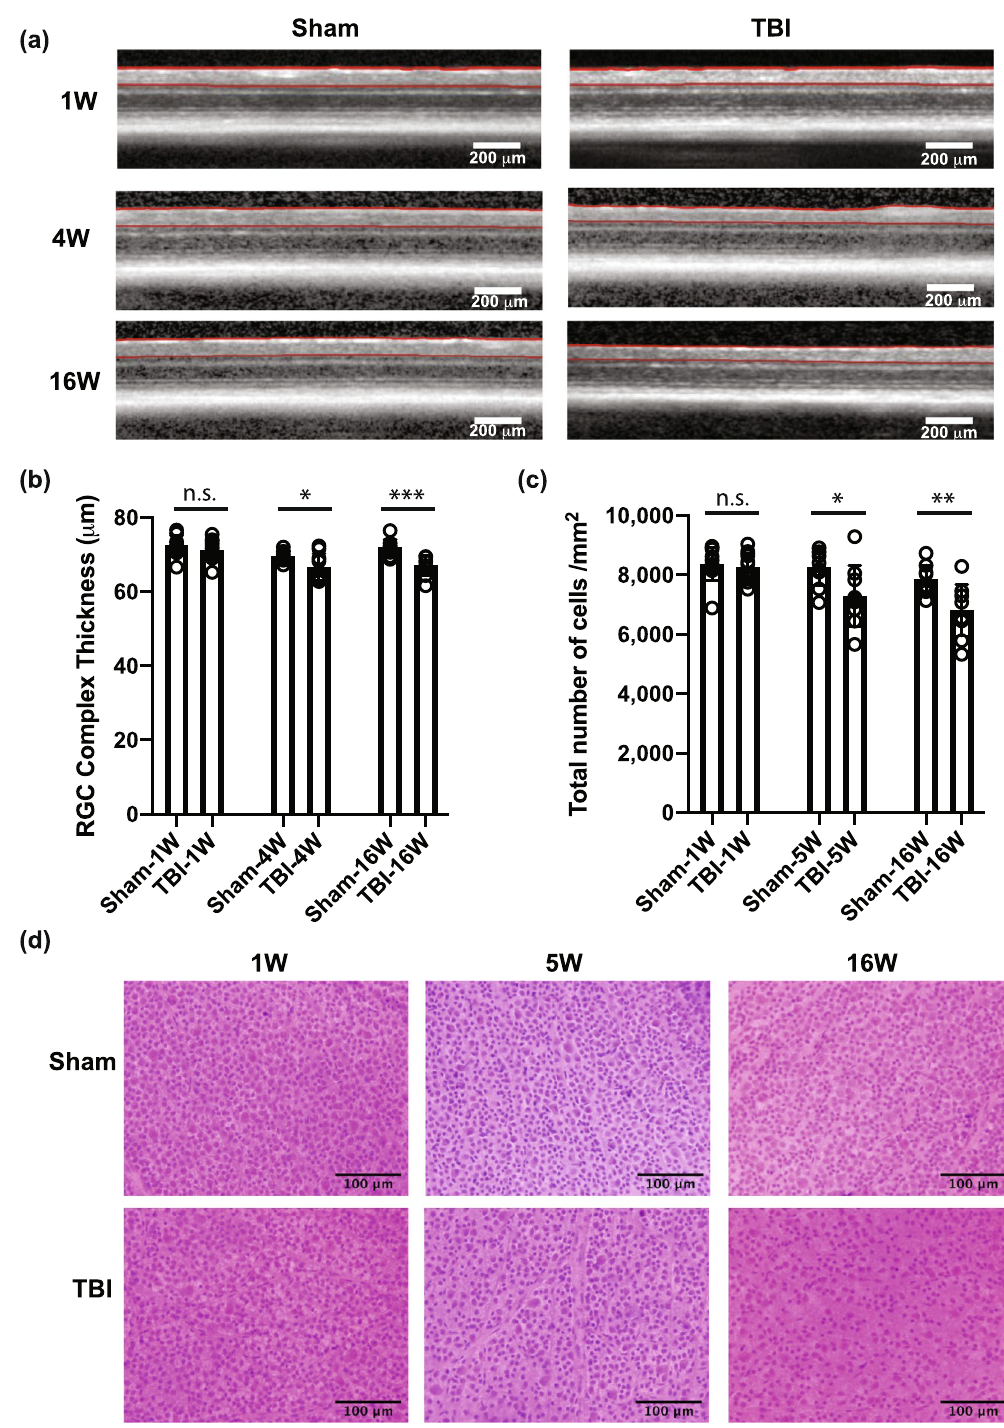
Figure 2. At 5 weeks post bTBI, cell loss from the ganglion cell layer was significant. ( a ) Images of the retina acquired by spectral domain optical coherence tomography (SD-OCT) at the indicated time points, with the ganglion cell complex (GCC) highlighted by red lines. ( b ) Representative images from the mid-central area of whole-mount retinas from sham and injured mice at the indicated time points, stained with hematoxylin and eosin (H&E). ( c ) Thickness of the GCC in vivo, as determined by SD-OCT at 1 week (1 W), 4 weeks (4 W), and 16 weeks (16 W) after bTBI. ( d ) Density of all cells in ganglion cell layer was quantified in whole-mount retinas stained with H&E at 1 W, 5 W, and 16 W after injury. Bars represent mean ± SD and each data point represents a biological sample; unpaired two tailed t -test analysis with Welch’s correction: * p < 0.05, ** p < 0.01, *** p < 0.001, n.s . not significant. The images were processed in Fiji 111 , the graphs were generated in Prism 8 software and the figure was assembled in Adobe Illustrator CC